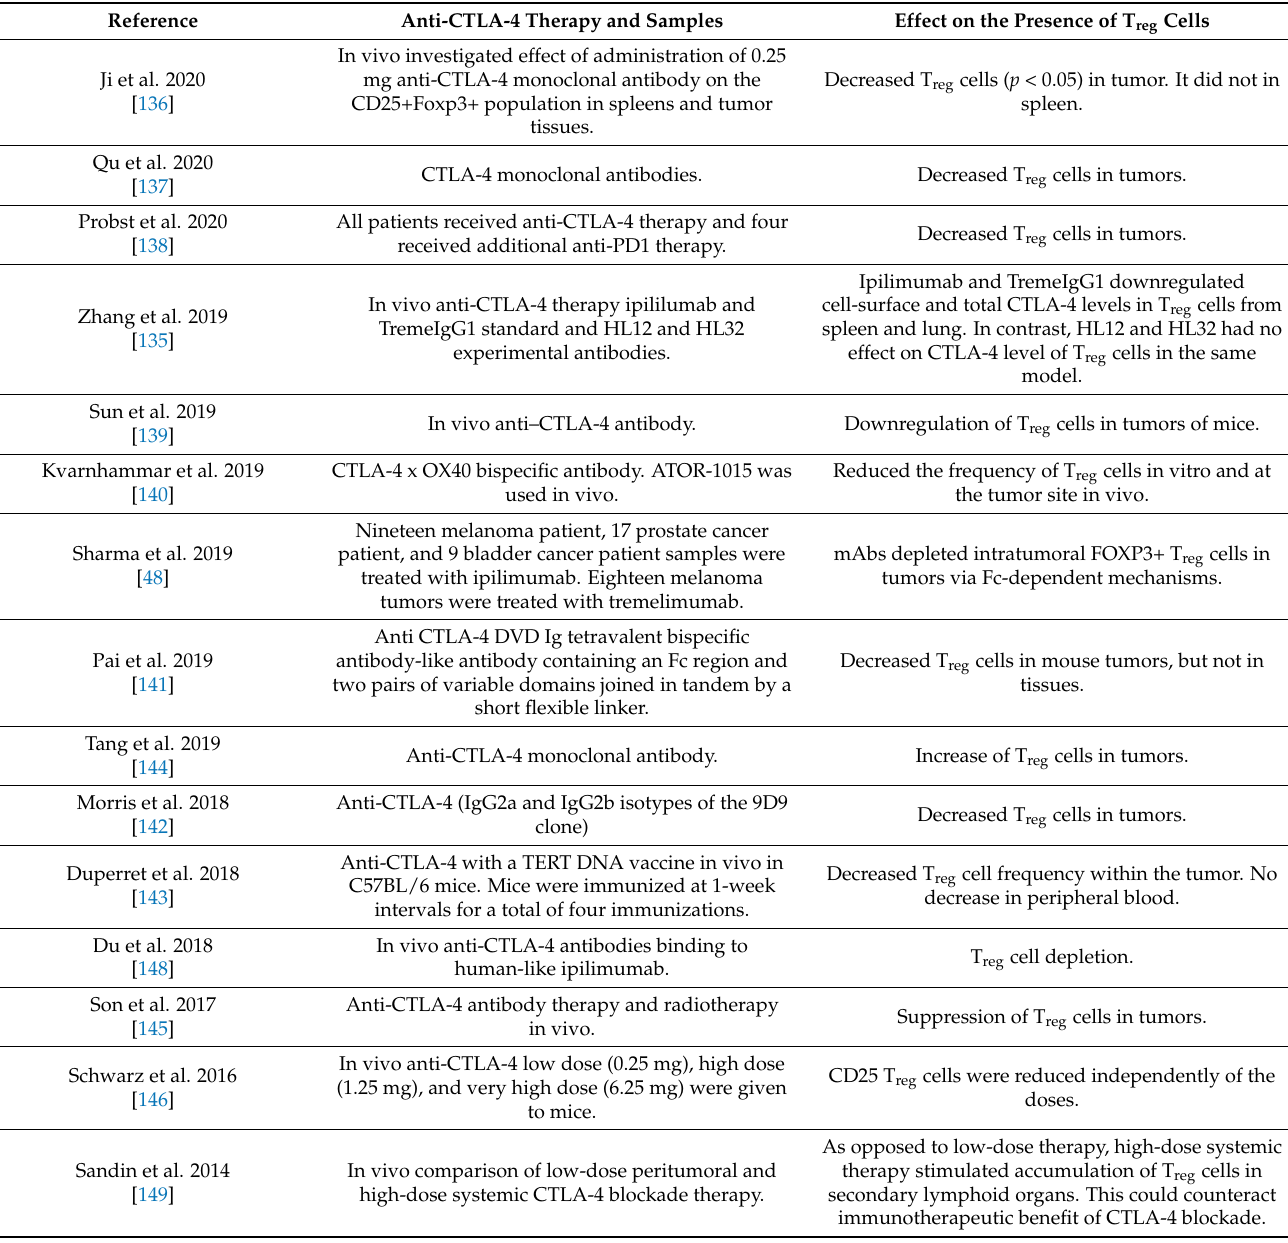
Table 1. Effects of anti-CTLA-4 therapy on T reg